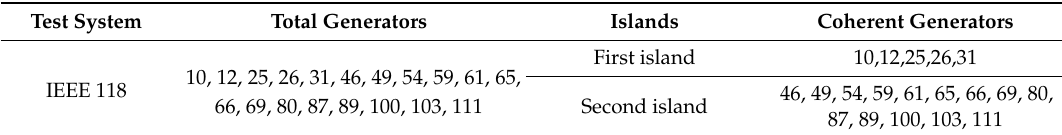
Table 3. Generator groups for the IEEE 118 bus system.